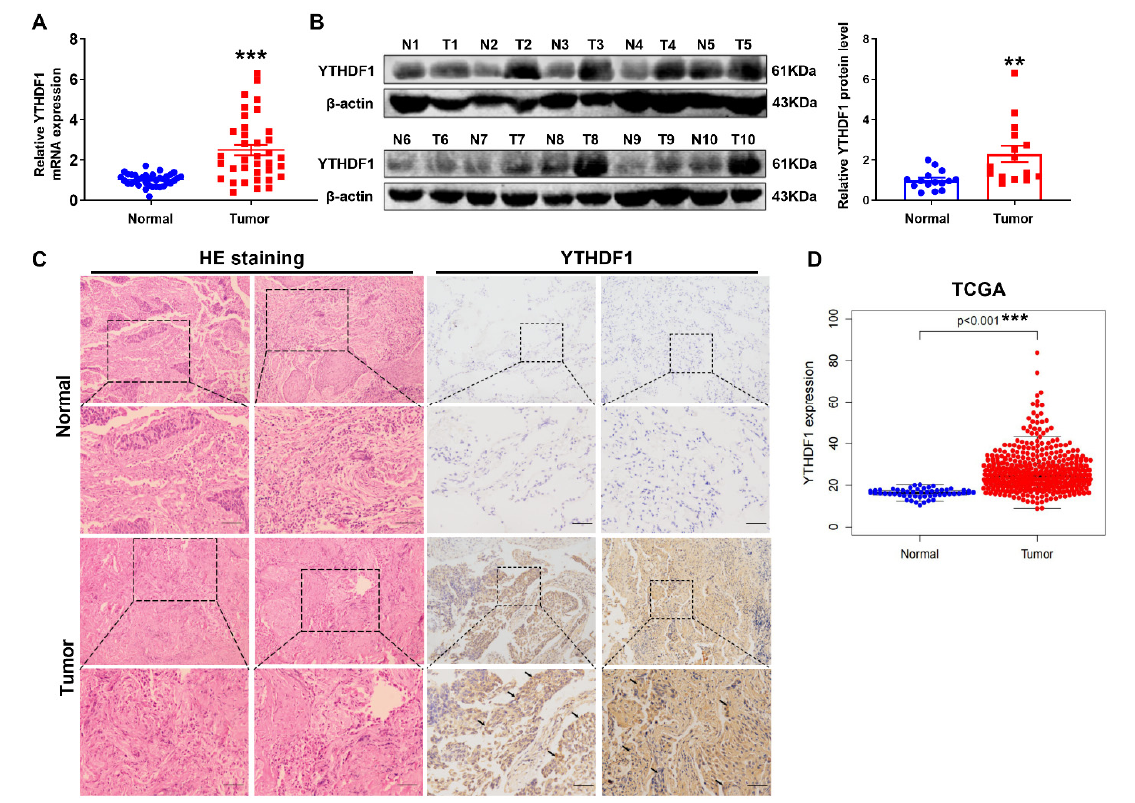
Figure 1. YTHDF1 is significantly expressed in lung cancer. (A) The mRNA level of YTHDF1 was analyzed by qRT ‐ PCR in lung cancer tissues and adjacent normal tissues. (B) The protein level of YTHDF1 was detected in clinical lung cancer tissues (T) compared with corresponding adjacent normal lung tissues (N). (C) Pathological changes of tumor were observed in HE staining. IHC staining of YTHDF1 in lung cancer tissues at 10 × magnification. Scale bar, 100 μ m. (D) YTHDF1 expression in lung cancer according to TCGA dataset. ** P < 0.01 and *** P < 0.001.